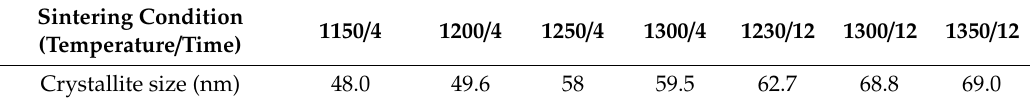
Table 1. Calculated crystalitte size of di ff erent sintered samples.